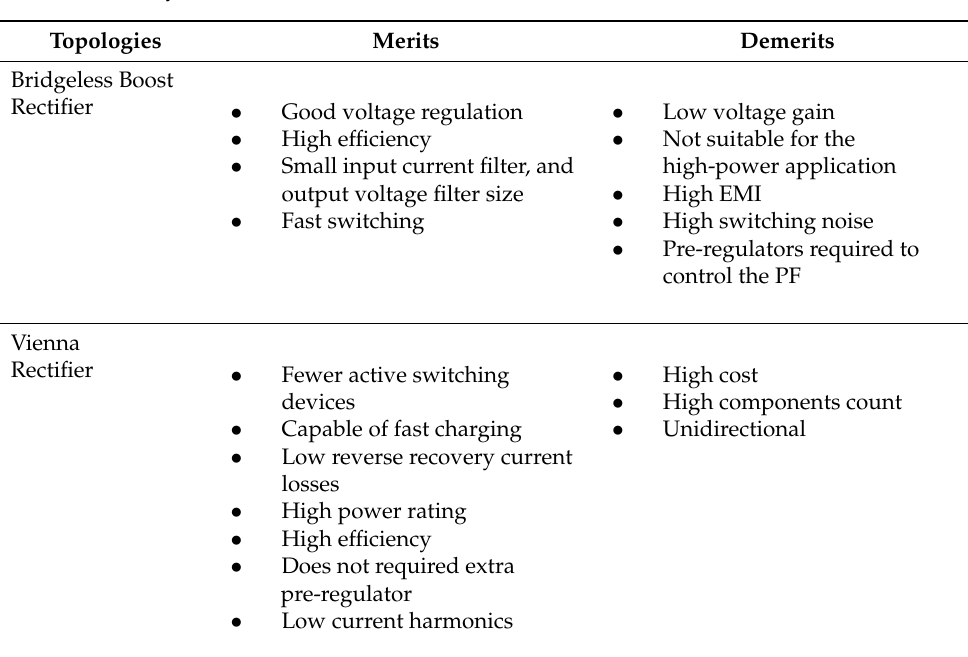
Table 9. Summary of offboard rectifiers.